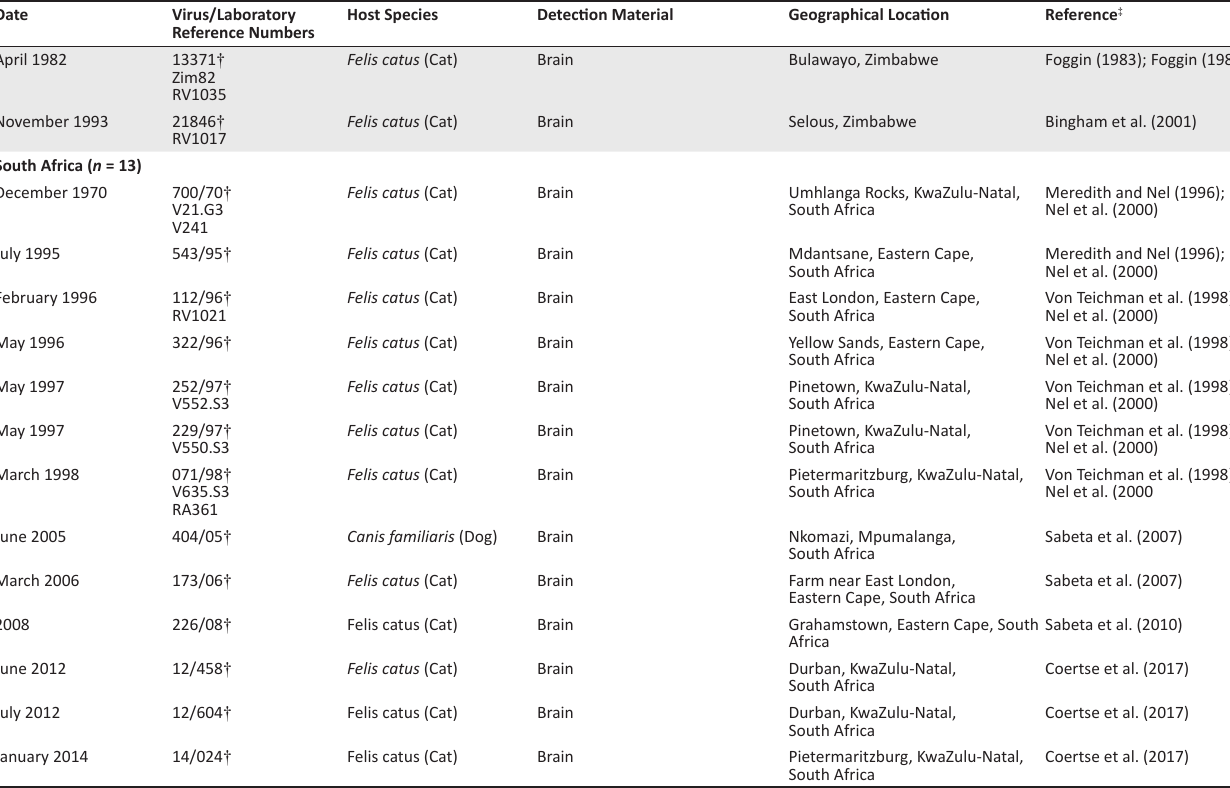
TABLE 1 (Continues...): Summary of all reported Mokola virus cases in Africa.